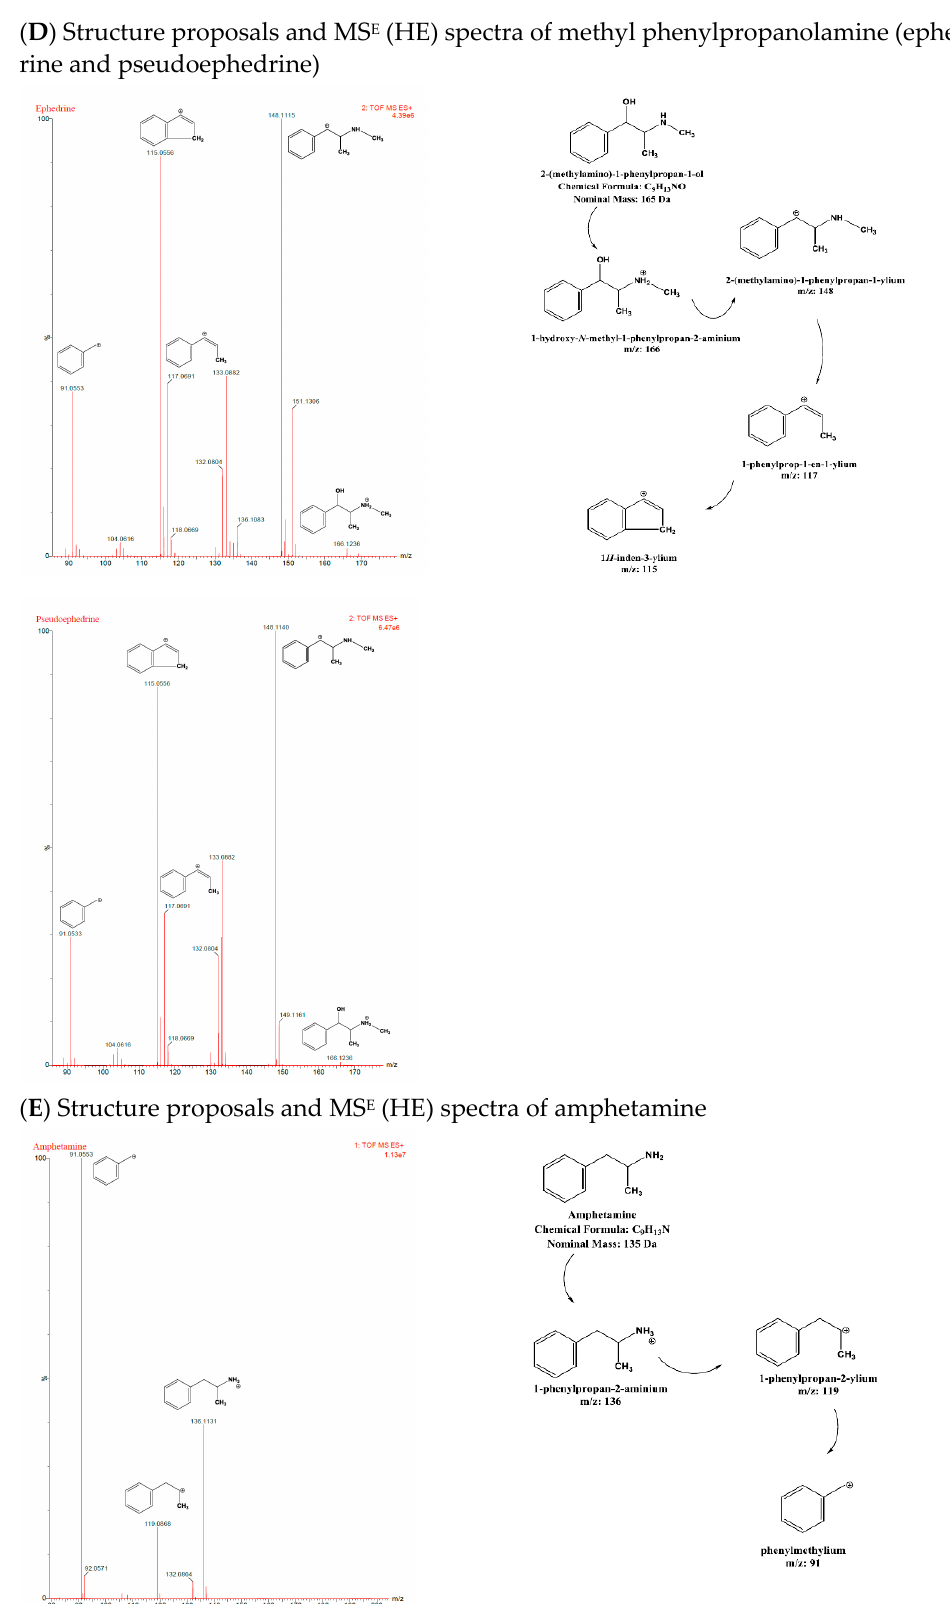
Figure 6. Chemical structure proposals for molecular ion fragmentation acquired at high colli- sion energy (HE) during qTOF-MS analysis for amphetamine-d 11 ( A ), ephedrine-d 3 ( B ), phenyl- propanolamine (norephedrine and cathine) ( C ), methyl phenylpropanolamine (ephedrine and pseu- doephedrine) ( D ), and amphetamine ( E